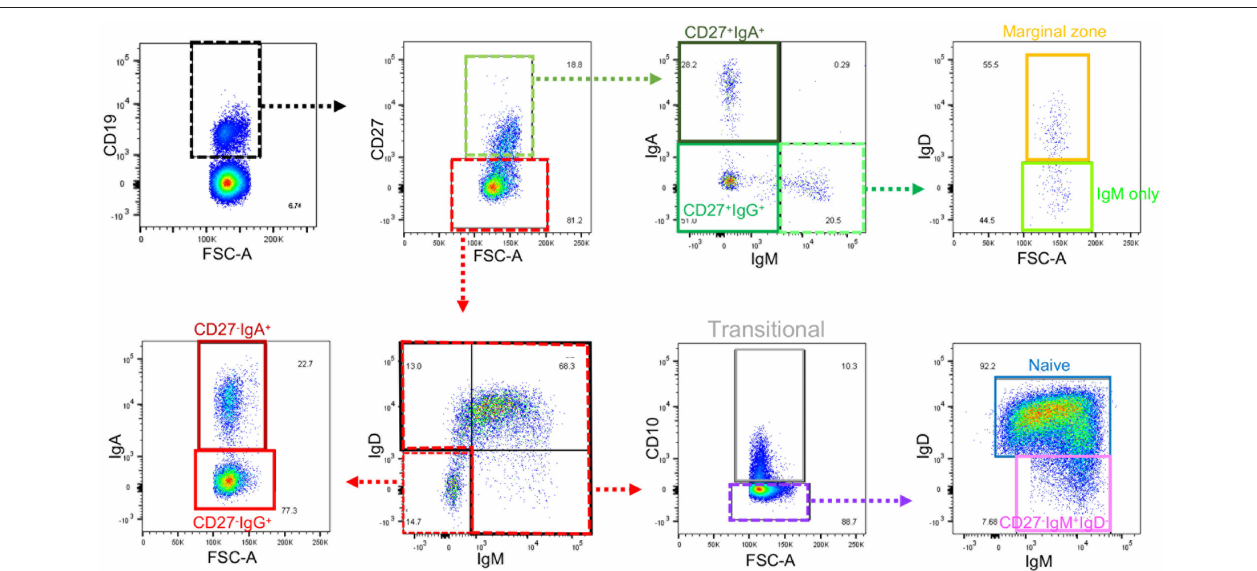
FIGURE 1 | Gating strategy for B cell subsets from blood. Gating strategy to define nine subsets of B cells using the same color code as the gating plan in Supplemental Table 4 . Further details of gating prior to the selection of CD19 + cells are in Supplemental Figure 1 . Gates that define intermediate populations are dotted. Gates that define final populations studied are